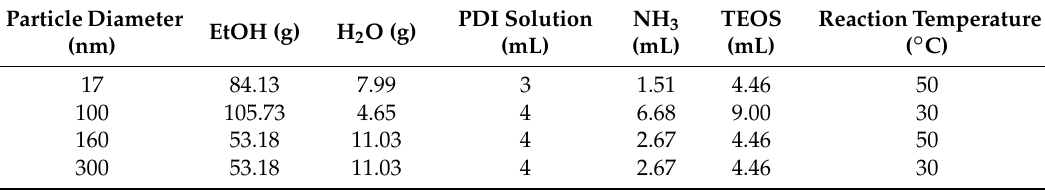
Table 1. Experimental details used for the preparation of the